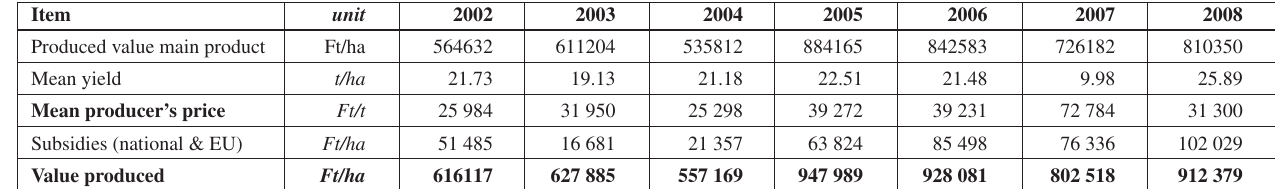
Table 1. The production value of apple growing in enterprises relevant on the market